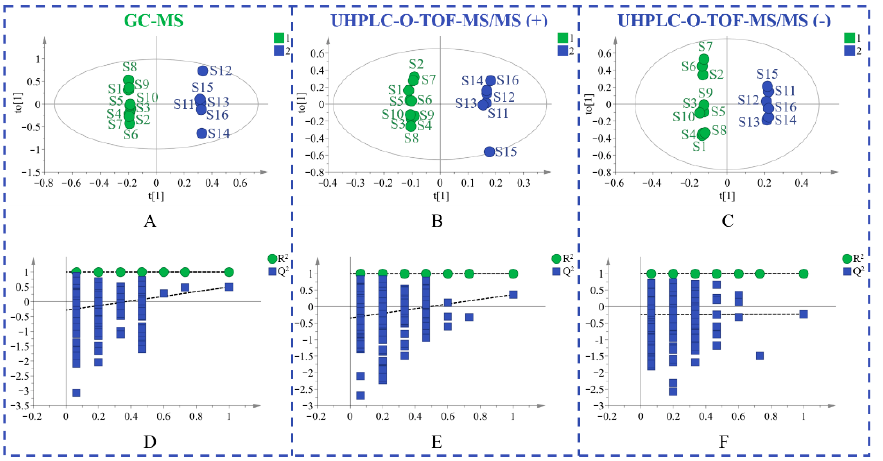
Figure 2. The OPLS-DA figures of two groups of S. tetrandra samples using GC-MS analysis ( A ), UHPLC-Q-TOF-MS/MS analysis in positive ( B ) and negative ( C ) ion model, validation of the model by a permutation test of GC-MS data ( D ), UHPLC-Q-TOF-MS/MS data in positive ( E ) and negative ( F ) ion model. (1: non-authentic origins; 2: geo-authentic origins).